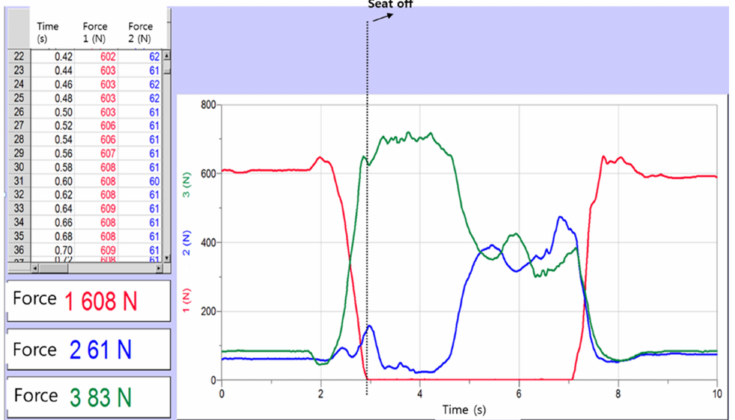
Figure 1. Force plate graph of left-side weight shifting during the sit-to-stand performance. Red line, buttock force plate; blue line, right foot force plate; green line, left foot force plate. Participants performed nine STS performances, three times in each STS method (three with even weight distribution, three with maximal weight shift to the right side, and three with maximal weight shift to the left side). Each standing method was alternately performed. A 1-min rest was given between trials to prevent